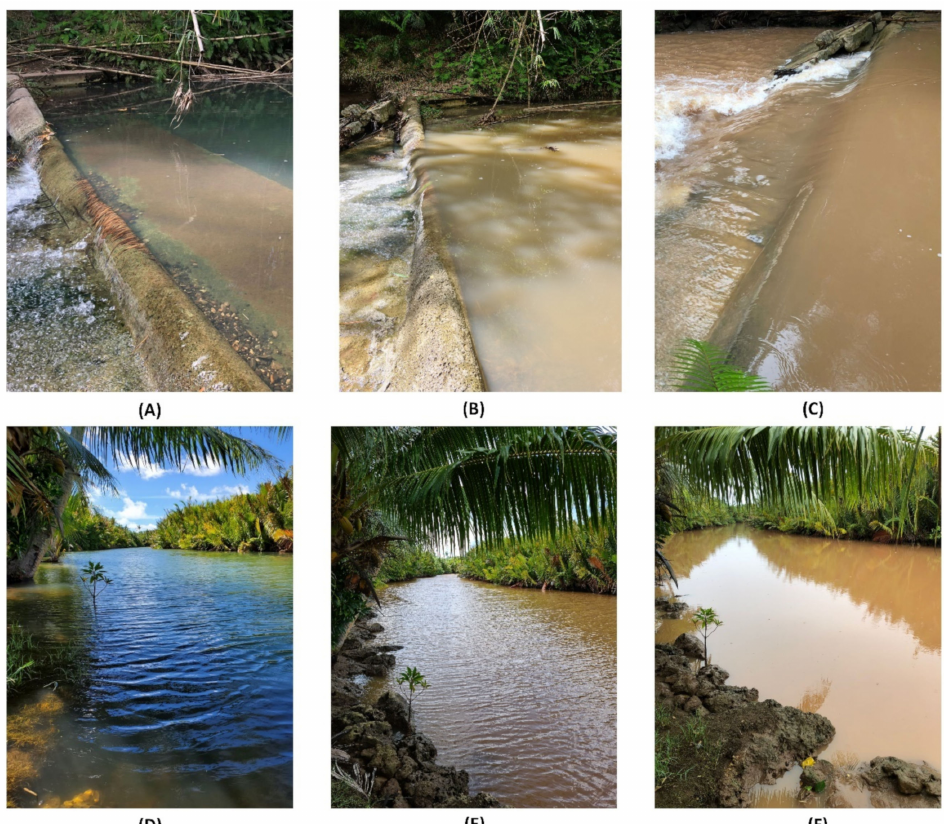
Figure 4. Site photos with respect to different sampling times. The top three photos were taken from Site 3, and the bottom three from Site 4. ( A , D ) were taken during a dry monsoon condition, ( B , E ) on 23 June 2021 (the day after Tropical Depression 06W), and ( C , F ) on 2 August 2021.